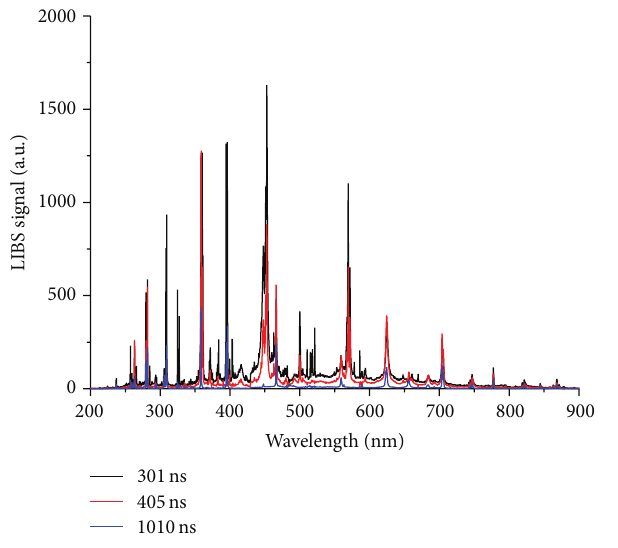
Figure 4: Time-resolved spectra.